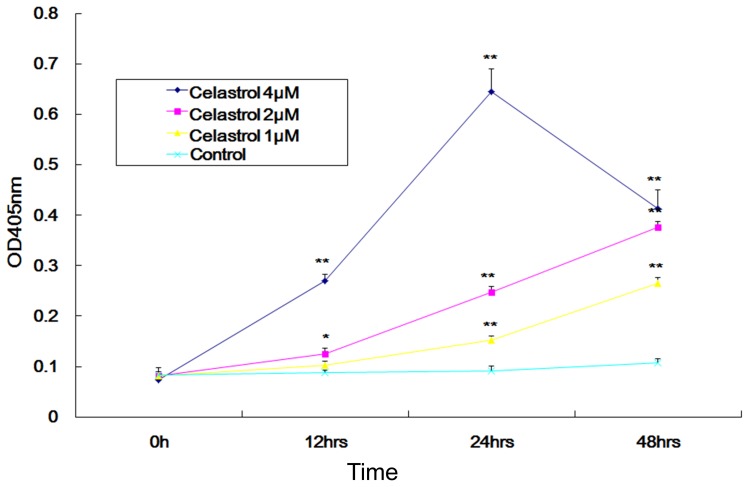
Celastrol induced caspase-3 activation.The cells were treated with 0 µM, 1 µM, 2 µM, and 4 µM celastrol for the indicated times. The whole cell extracts were prepared and subjected to enzymatic activity of caspase-3 by colorimetric substrate Ac-DEVD-pNA. The amount of yellow color at 405 nm indicating Caspase-3 activation fold was compared in the celastrol treated group to 0 h. point, mean; bars, SD (n = 3). *, p<0.05; **, p<0. 01.